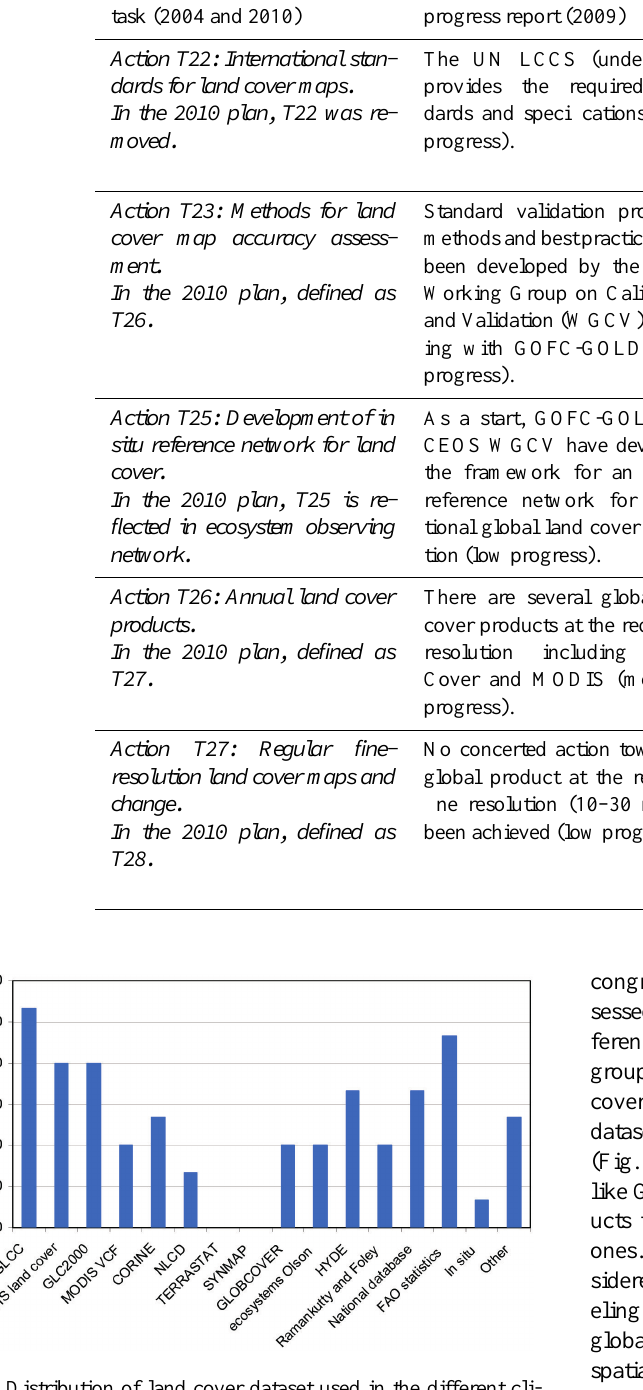
Fig. 2. Distribution of land cover dataset used in the different cli- mate modeling applications, according to the respondents to the as- sociated users’